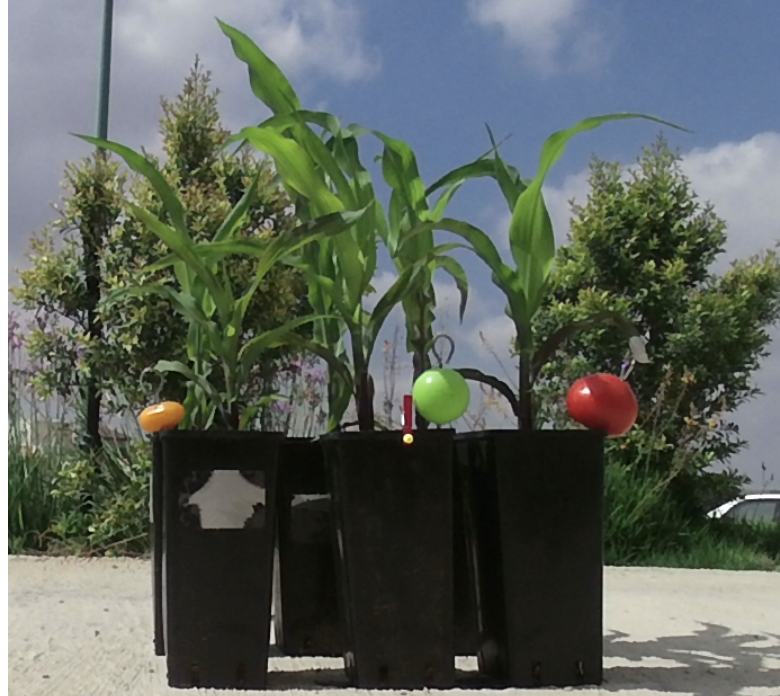
Figure 2. The experimental setup as captured by the Kinect sensor from 1 m. Six corn plants in black plastic pots arranged in two rows. Added tomatoes—a red tomato, an orange cherry tomato. Two plastic balls for size measurements—a larger green ball and a smaller yellow